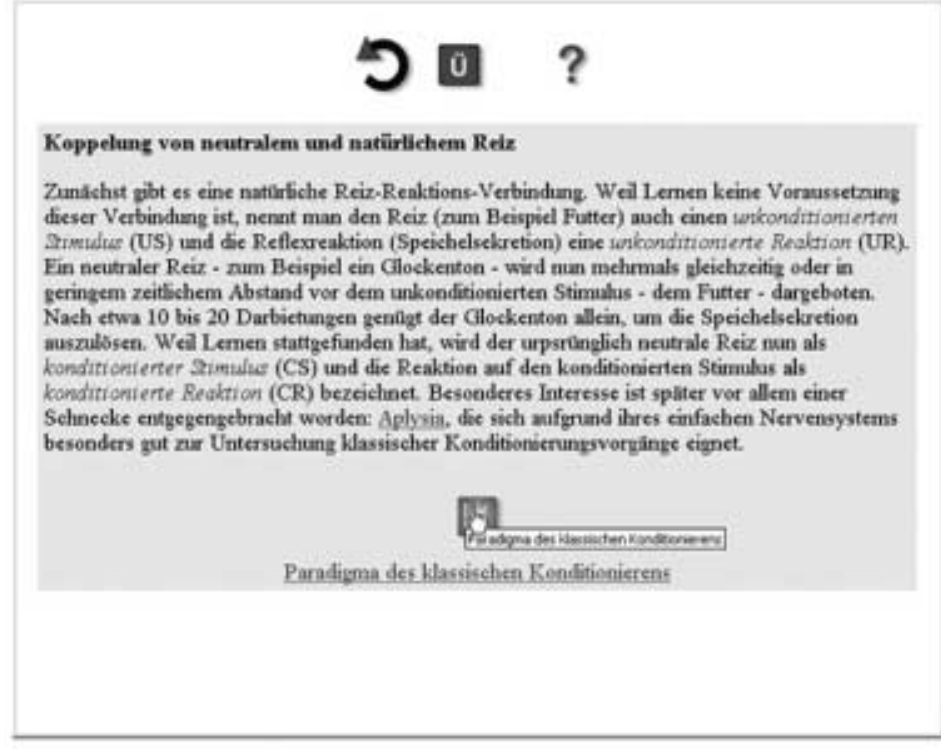
Figure 2. Example content page of the hypertext with one embedded link, showing the typical page layout and functions (black and white screenshot of the colored